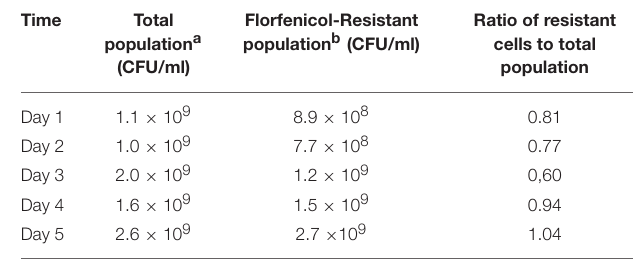
TABLE 4 | In vitro Salmonella serovar transfer frequency of Newport multi-drug resistance plasmid. Salmonella serovar a